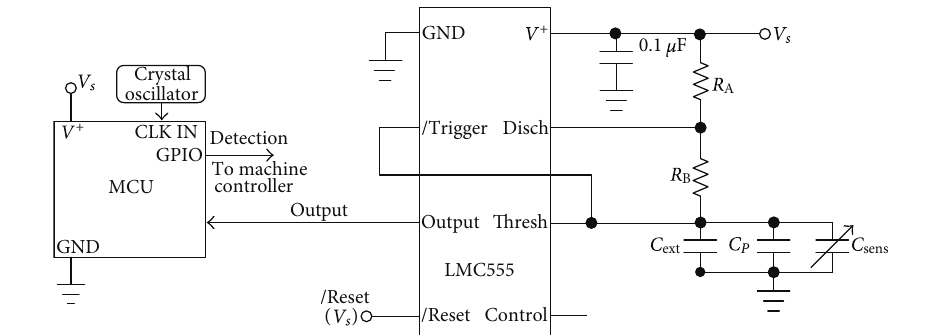
F 20: Front-end circuitry for capacitance change detection.